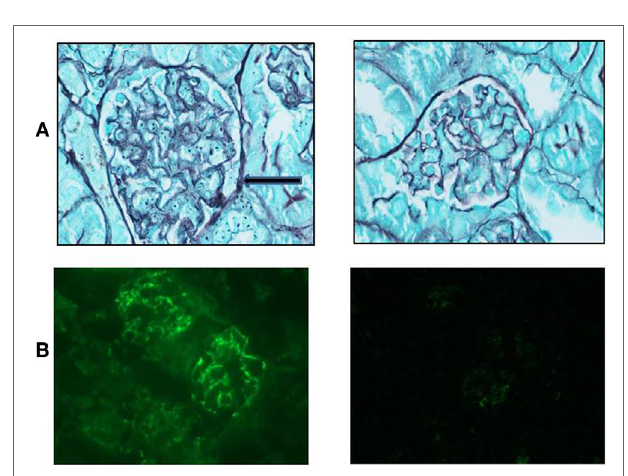
FigUre 3 | (a) Silver staining shows a typical railway pattern in the glomeruli of control-treated mice (left panel, black arrow). Semaphorin3A (sema3A)- treated mice remained protected with minimal glomerular damage (right panel). (B) Increased IgG deposition is significant in the glomeruli of control-treated mice (left panel) and is minimal in sema3A-treated mice ( p < 0.01).